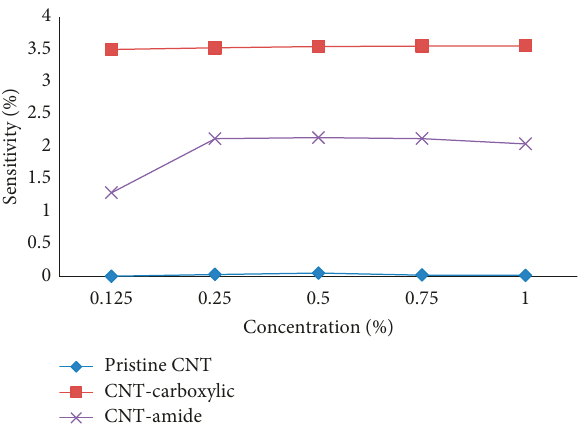
Figure 4: Sensitivity of the CNT upon exposure to benzene